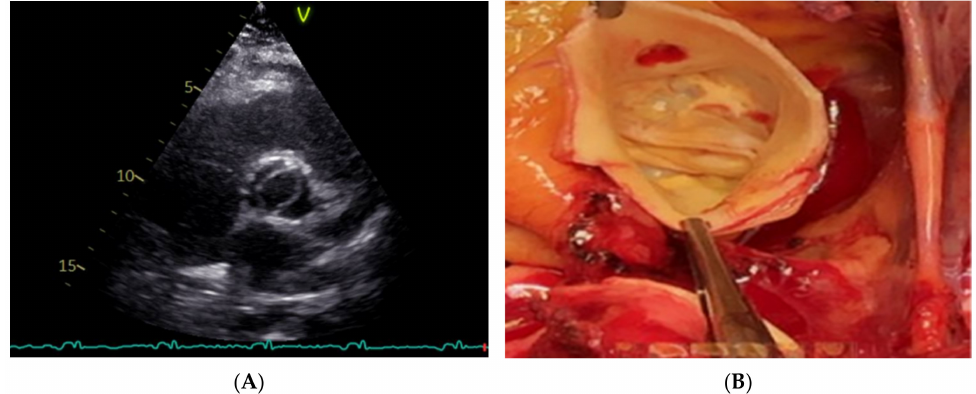
Figure 7. ( A ) TTE. Right non-coronary cusps fusion. ( B ) In the picture from operation theater, it is possible to appreciate the fusion between the right cusp and the non-coronary cusp. Three sinuses are still viewed. Commissural geometrical juxtaposition forms a 180-degree